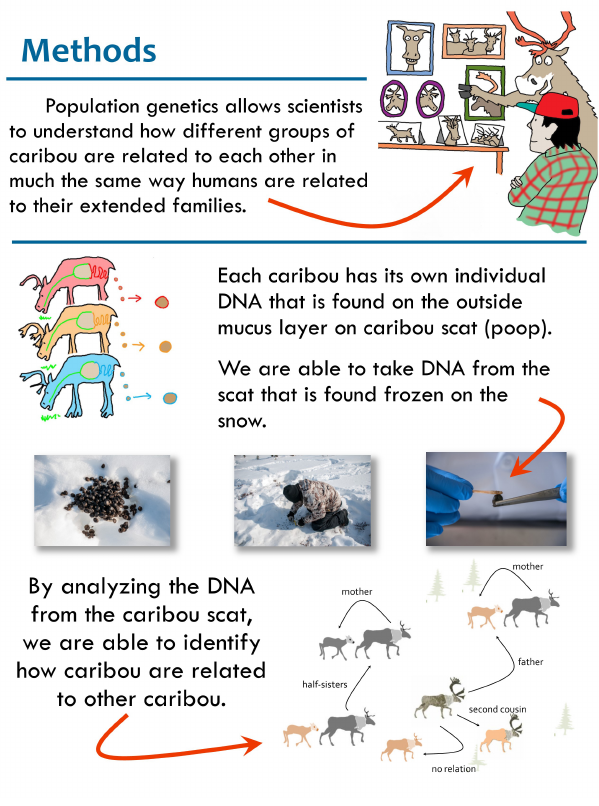
Fig. 3 . Diagram used in PowerPoint presentations and posters with a visual description of genetic methods. The top two illustrations were drawn by Doug Urquhart and the caribou relationship drawing, photos, and overall design were developed by the lead